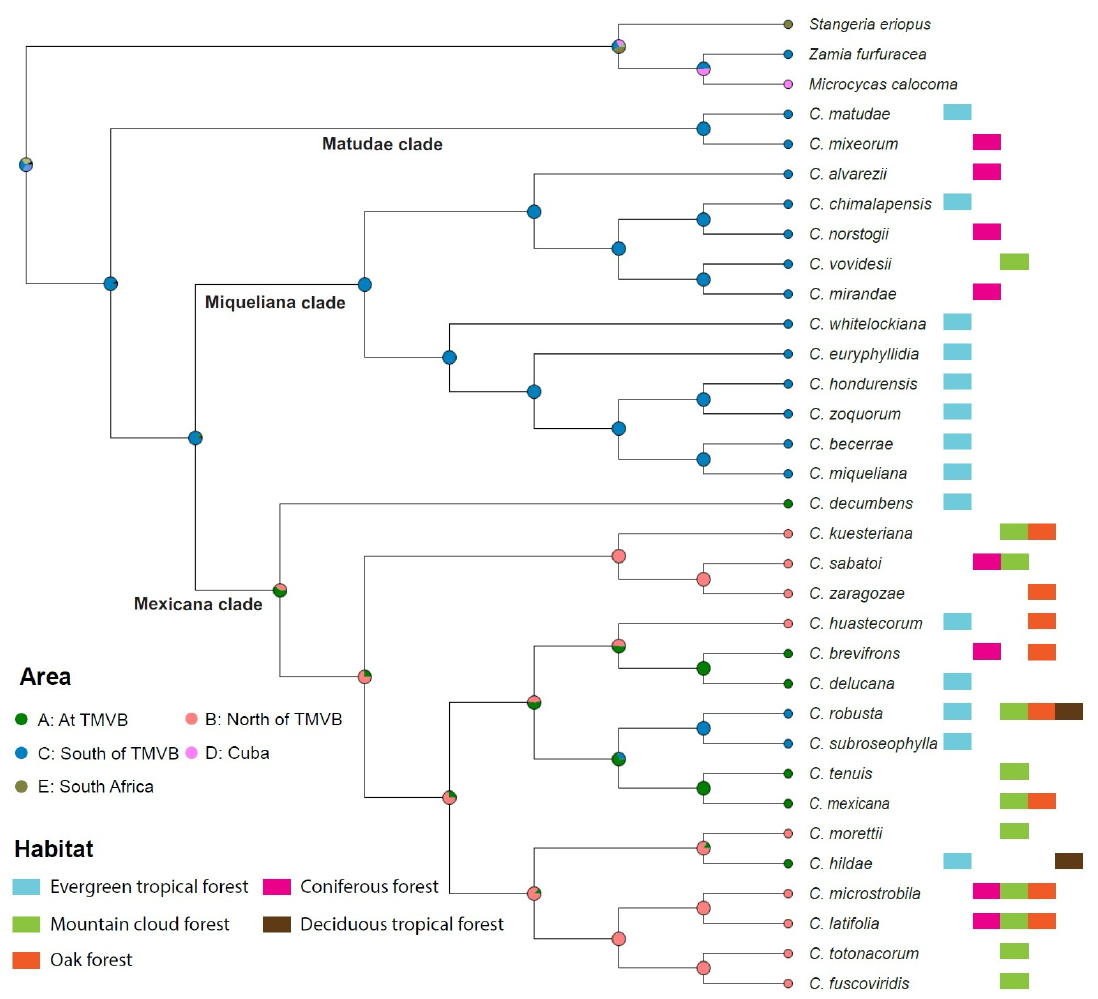
Figure 5. Ancestral area reconstruction for the genus Ceratozamia based on the combined data matrix of 50 single-copy nuclear genes constrained to the ML tree of the concatenated dataset with all codon positions included (nt dataset). The geographical extents of the three areas with reference to the Trans-Mexican Volcanic Belt (TMVB) as (A) at TMVB, (B) north of TMVB, and (C) south of TMVB considered in the analysis. The colored circles on the nodes show the most likely ancestral areas reconstructed by BioGeoBEARS. Current distributions are indicated at the branch tips. Habitat diversity for each Ceratozamia species is given to the right of the species name. Table 2. Ancestral area probability (% age) based on Figure 4 for each of the key nodes of the genus Ceratozamia .